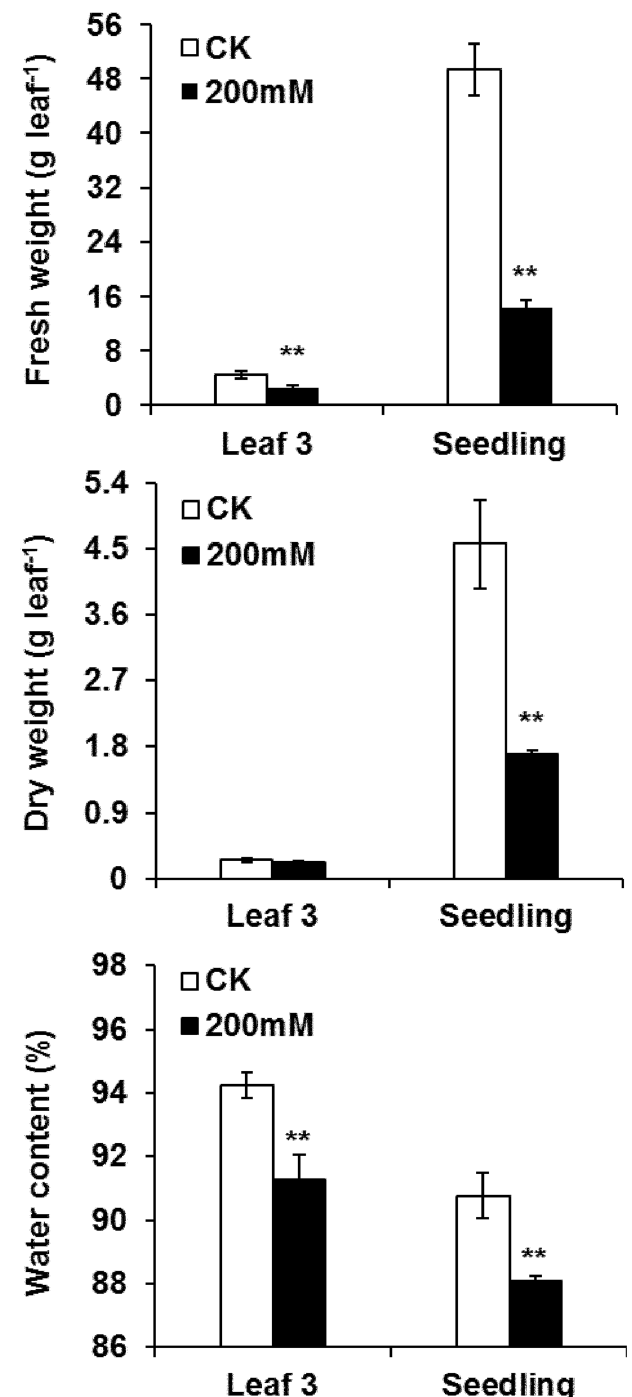
Fig 1. Effects of salt-stress treatments on plant biomass in B . napus ‘ Nannongyou No. 3 ’ . Values shown are means ± SD from three biological replicates. ** indicates a significant difference (compared with the control) at p <